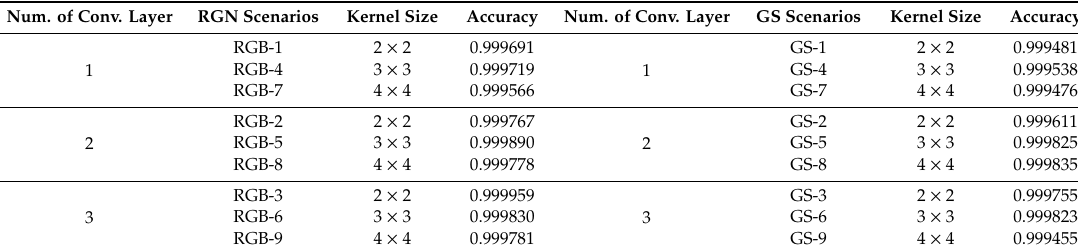
Table 10. Comparison of Accuracy by size of kernel in multiple classification in case of KDD. Num. of Conv. Num. of